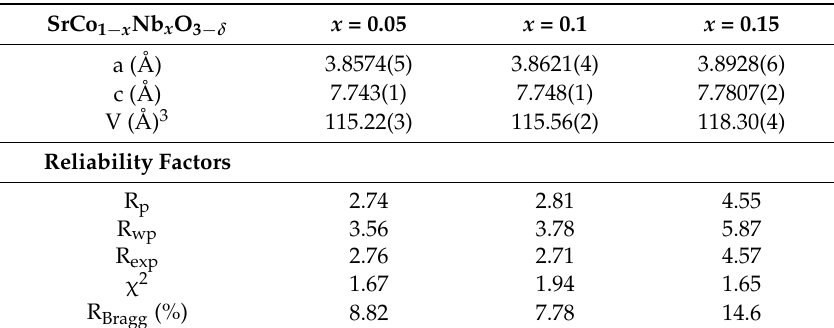
Table 1. Unit-cell parameters and discrepancy factors after the Rietveld refinements of the samples studied by X-ray diffraction (XRD) at room temperature. Values for x = 0.05 are taken from ref. [18], reprinted and adapted from [18], with permission from © 2014